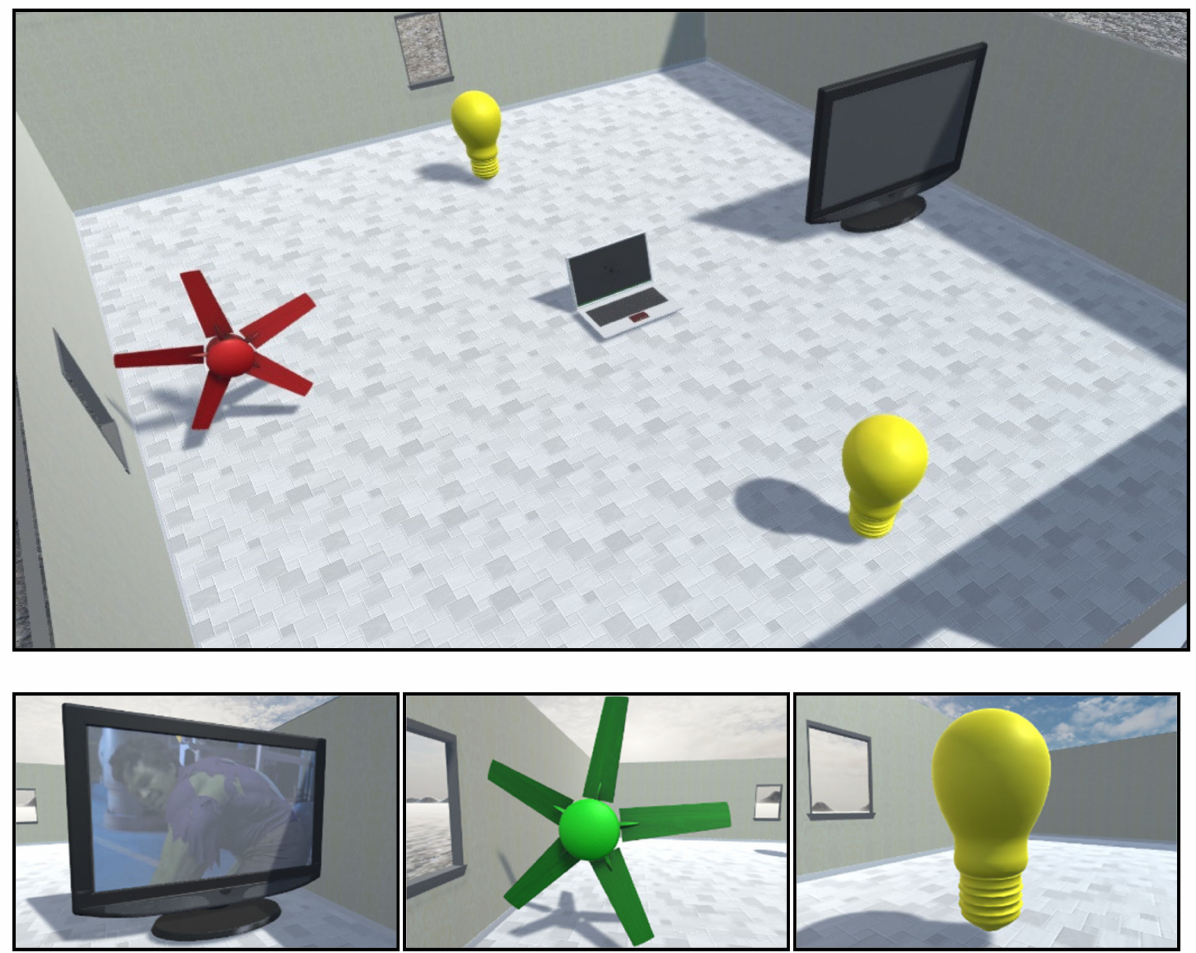
Figure 8. A 3D virtual environment composed of a coordinator and profiled virtual devices. A display, a pair of lamps, and a fan can be